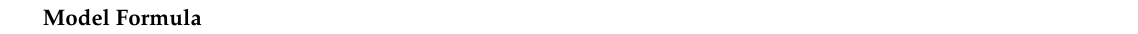
Table A25. Model selection procedure by “all subsets”, according to AICc, from the full model of the relationship between the 15 climate variables and the year, and the overall timing of migration as measured by Annual Anomaly (AA) for the Pied Flycatcher Ficedula hypoleuca caught at Bukowo, Poland, in 1982–2017. Symbols as in Table A19. The best model, discussed in the text, in bold